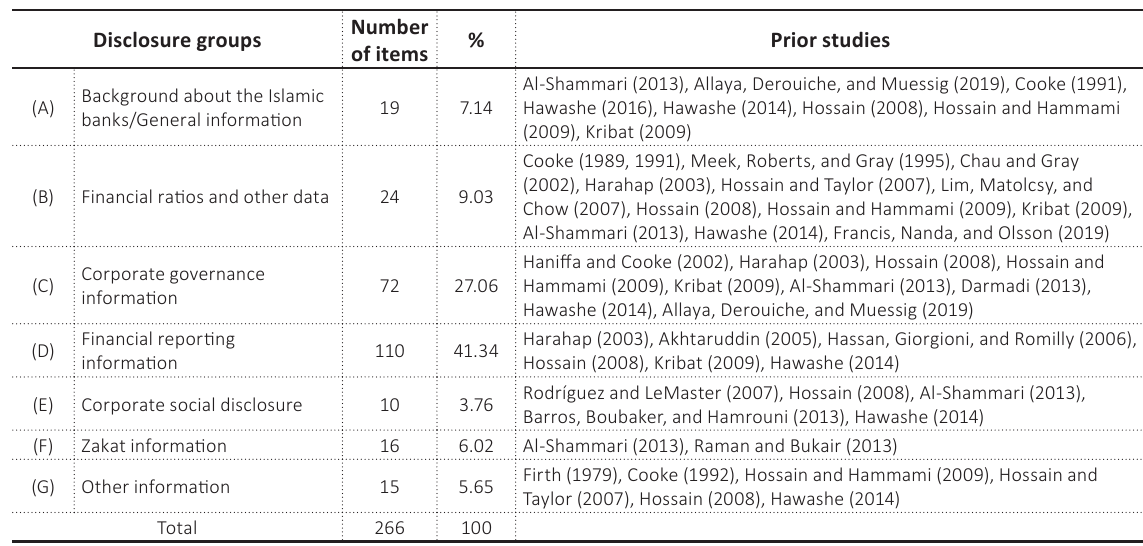
Table 2. Voluntary information categories